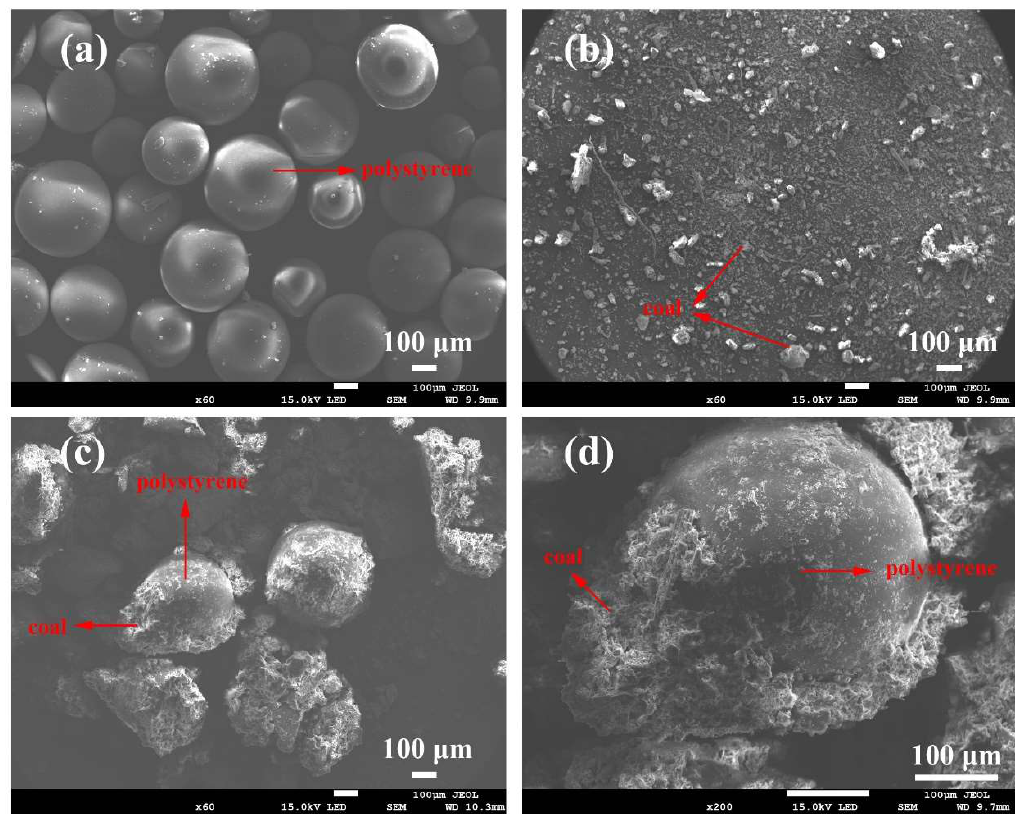
Figure 8. Scanning electron microscopy (SEM) photographs: ( a ) polystyrene, ( b ) coal after conditioning, and ( c , d ) coal and polystyrene after conditioning.